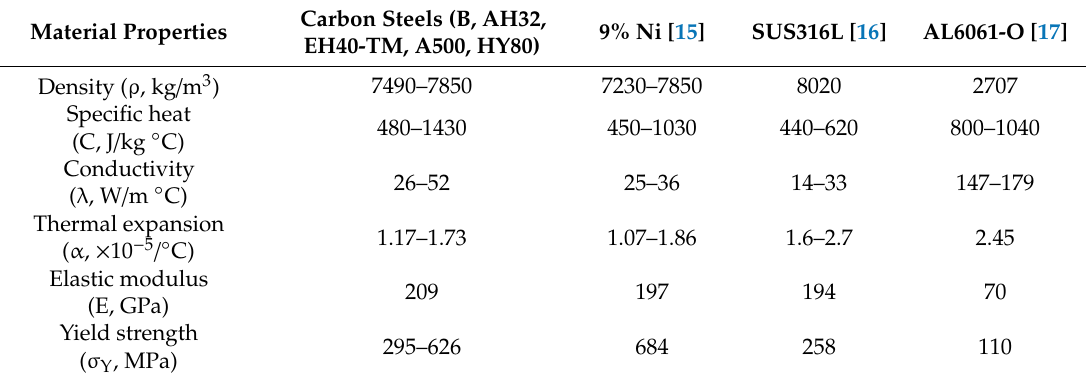
Table 4. Thermomechanical property ranges of various